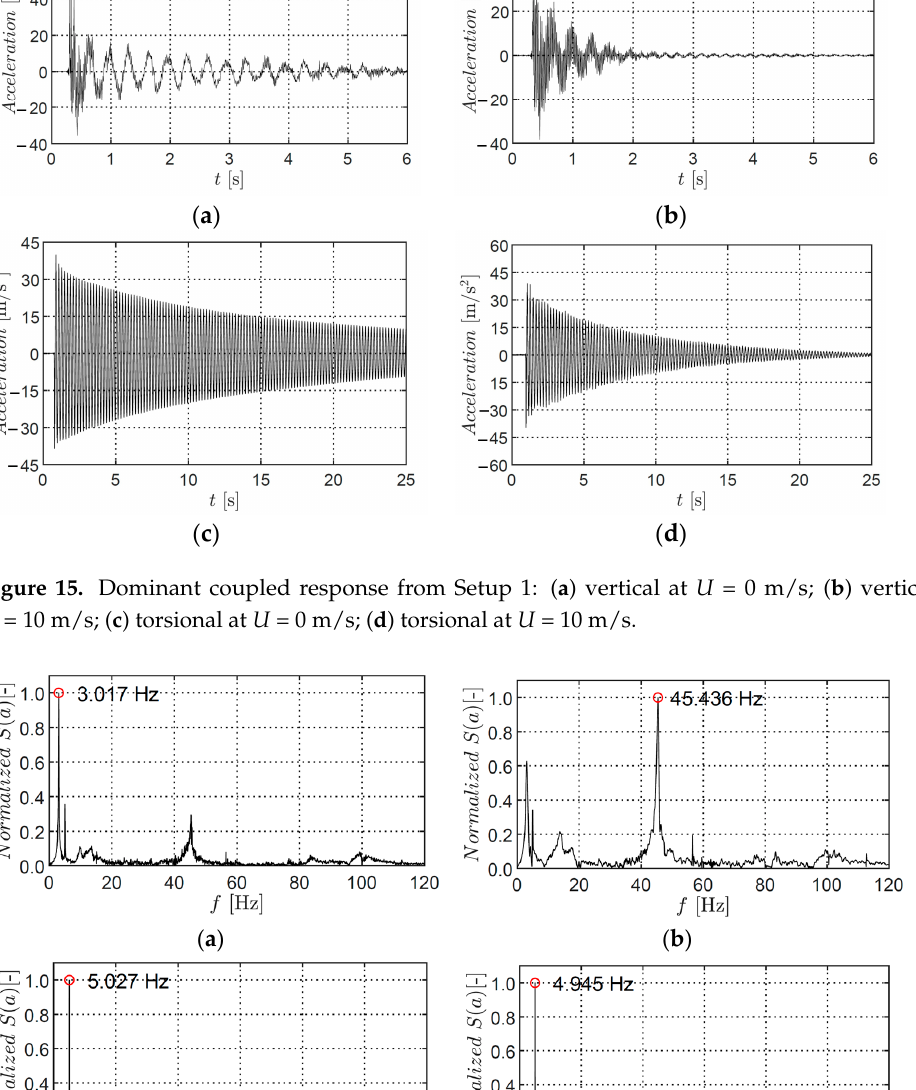
Figure 16. FFTs of the dominant coupled responses from Setup 1: ( a ) vertical response at U = 0 m/s; ( b ) vertical response at U = 10 m/s; ( c ) torsional response at U = 0 m/s; ( d ) torsional response at U = 10 m/s.